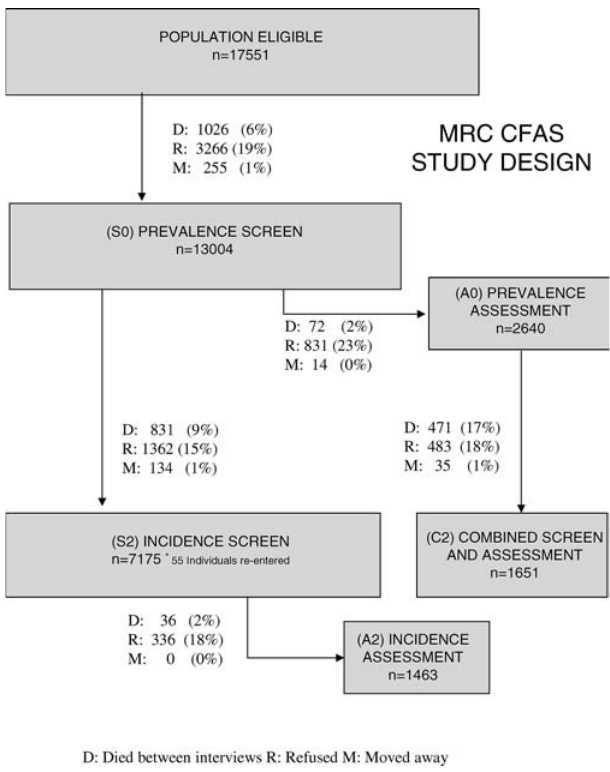
Figure 1. Flow Chart of Individuals Contributing to the Incidence Analysis D indicates died between waves, R indicates refused, and M indicates moved away from the study areas between waves. DOI: